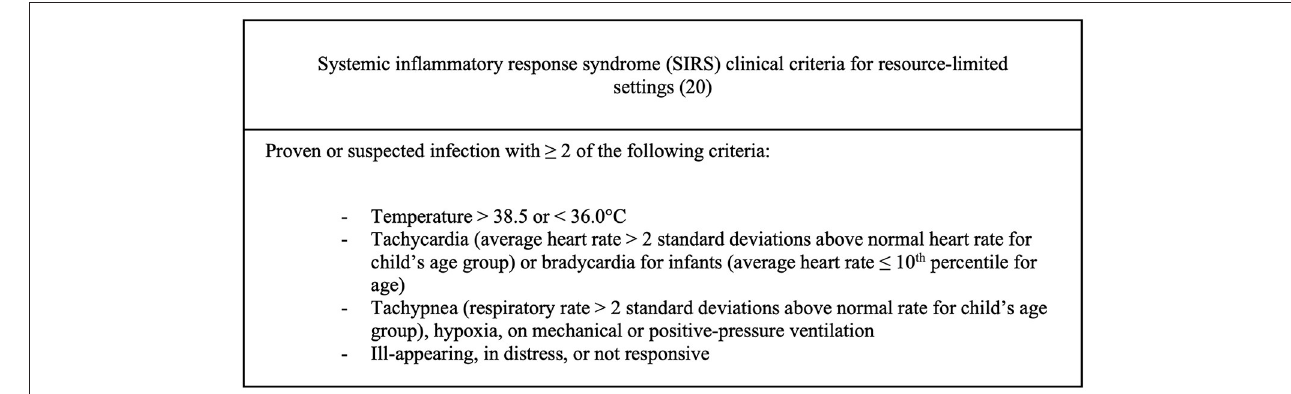
FIGURE 1 | SIRS criteria.